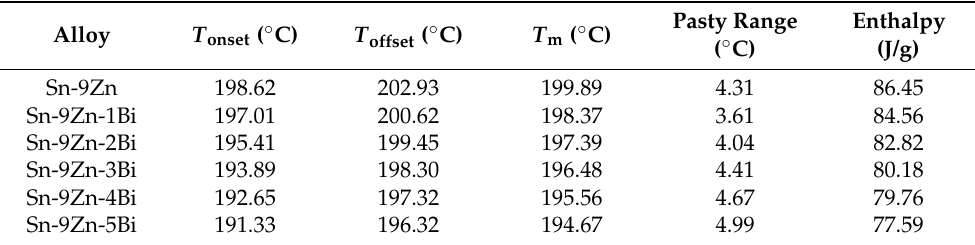
Table 2. DSC results for various solder alloys.